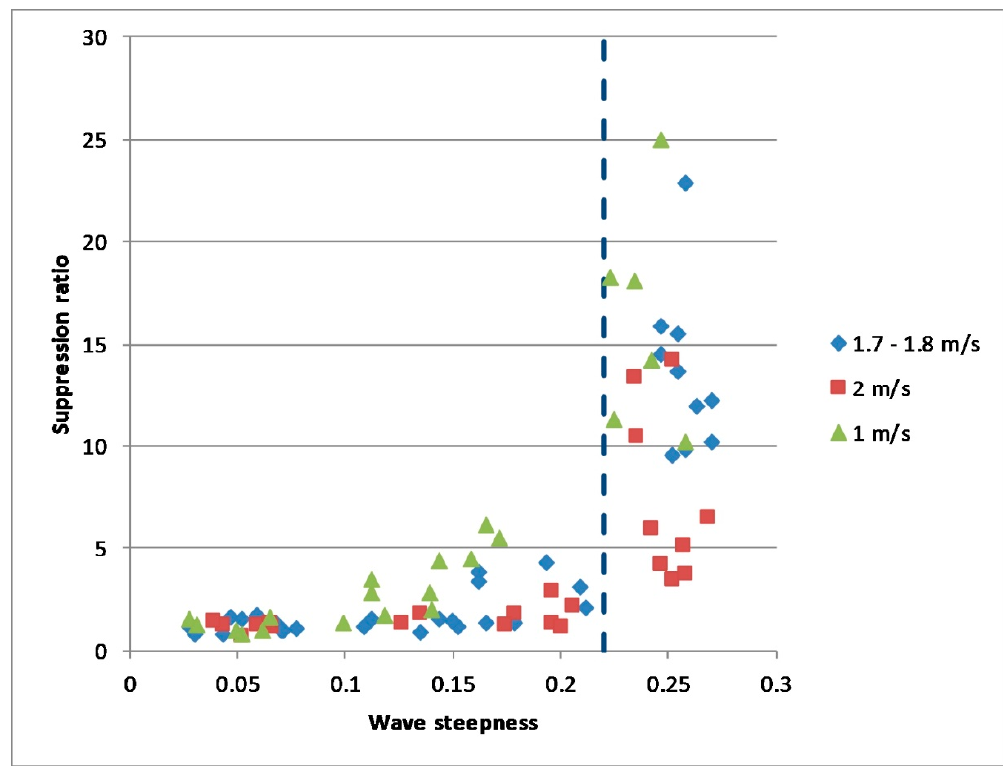
Figure 14. Suppression ratio vs. LF wave steepness. The dashed line separates the steepness values of non-breaking and breaking LF waves.